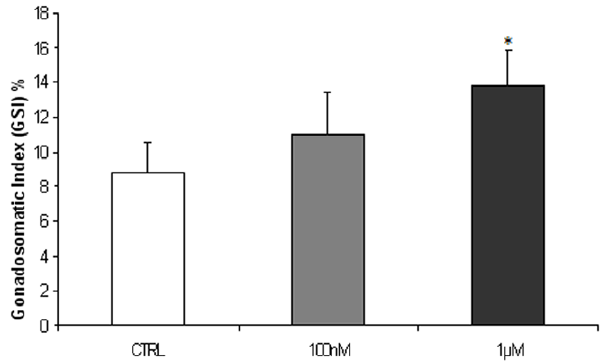
Figure 2. Effects of melatonin on GSI. Effect of MEL 100 nM and 1 m M on gonado- somatic index. n=15 per group. Error bars indicate mean 6 S.D. Asterisks indicate statistical significant differences respect to control group (P , 0.05).